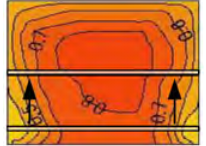
Figure 13. Changed position of the opening at the windward face ( TPU Aerodynamic Database [9], mod- ified).